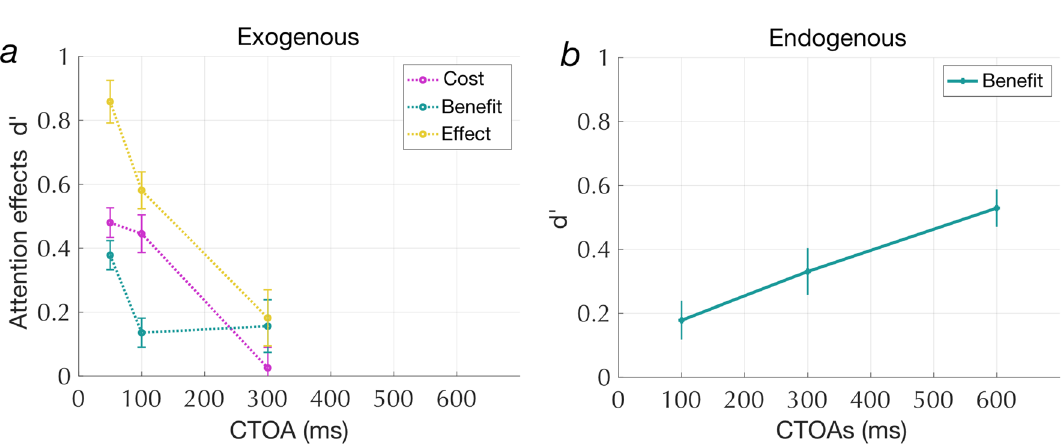
Figure 3. ( a ) Time course of cue benefits, cue cost and cue effects with exogenous cues CTOAs: 50, 100, 300 ms); ( b ) Endogenous cue benefits as a function of CTOAs (100, 300, 600 ms). Error bars represent